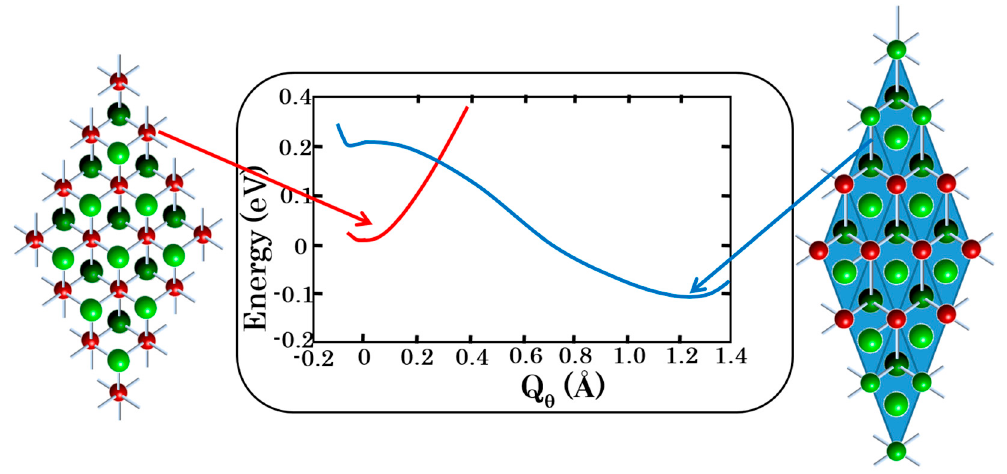
Figure 9. PJTE-induced bistability in the crystal LiCuO 2 : the undistorted spin-triplet magnetic configuration (left) is by ~0.17 eV higher in energy than the strongly tetragonal-distorted zero-spin, diamagnetic phase (right). The Cu 3+ ions are shown in red, while the oxygens are painted green (face plane) and dark green (rear plane).